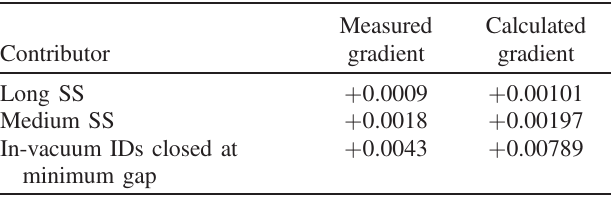
TABLE IV. Comparison of effective gradients (T m − 1 ) deduced from the measurements at a beam current of 300 mA with predicted values (model A) for each type of vacuum